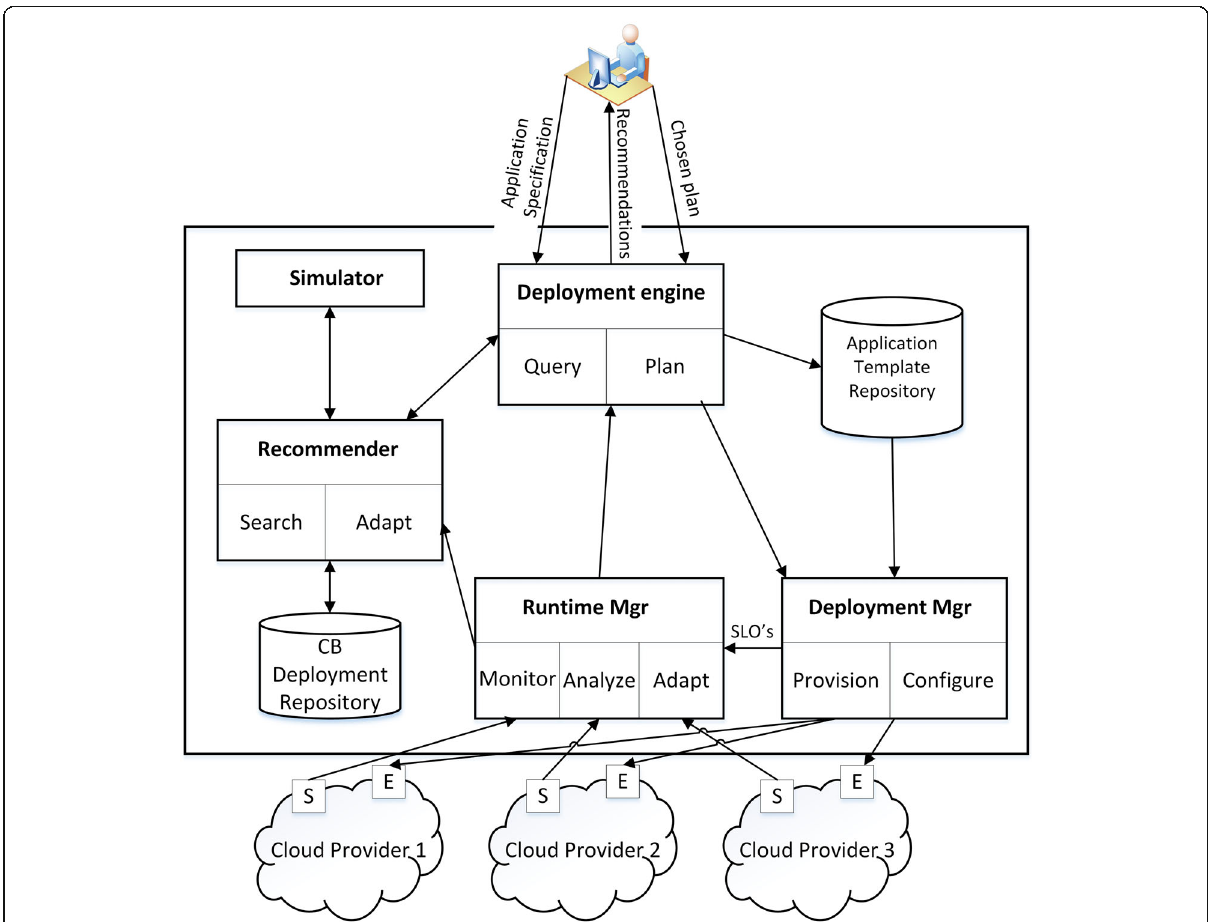
Fig. 2 A block diagram of QuARAM